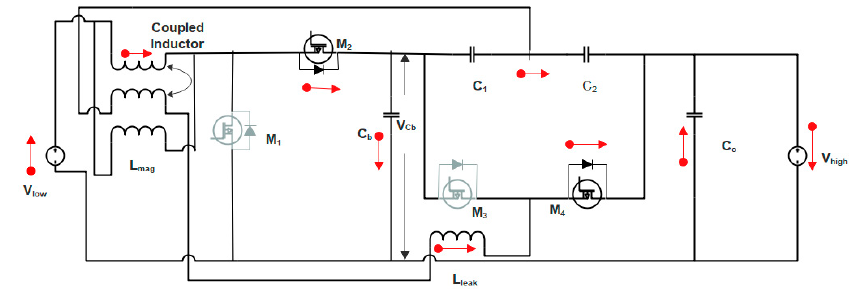
Figure 10. Equivalent circuit for mode VIII.